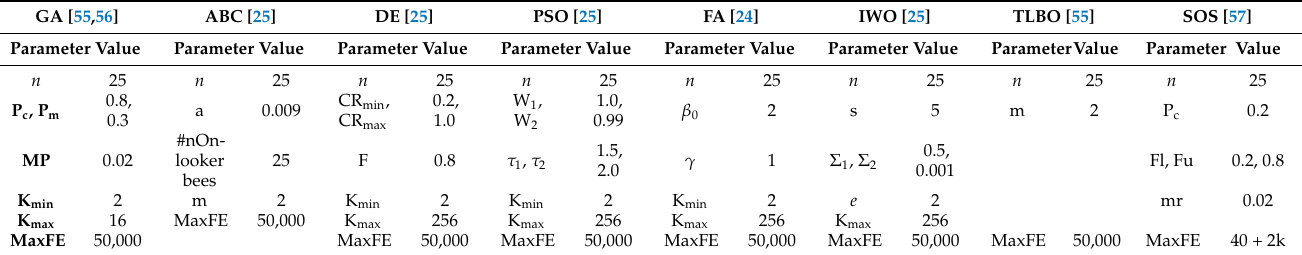
Table 1. Parameter Setting of